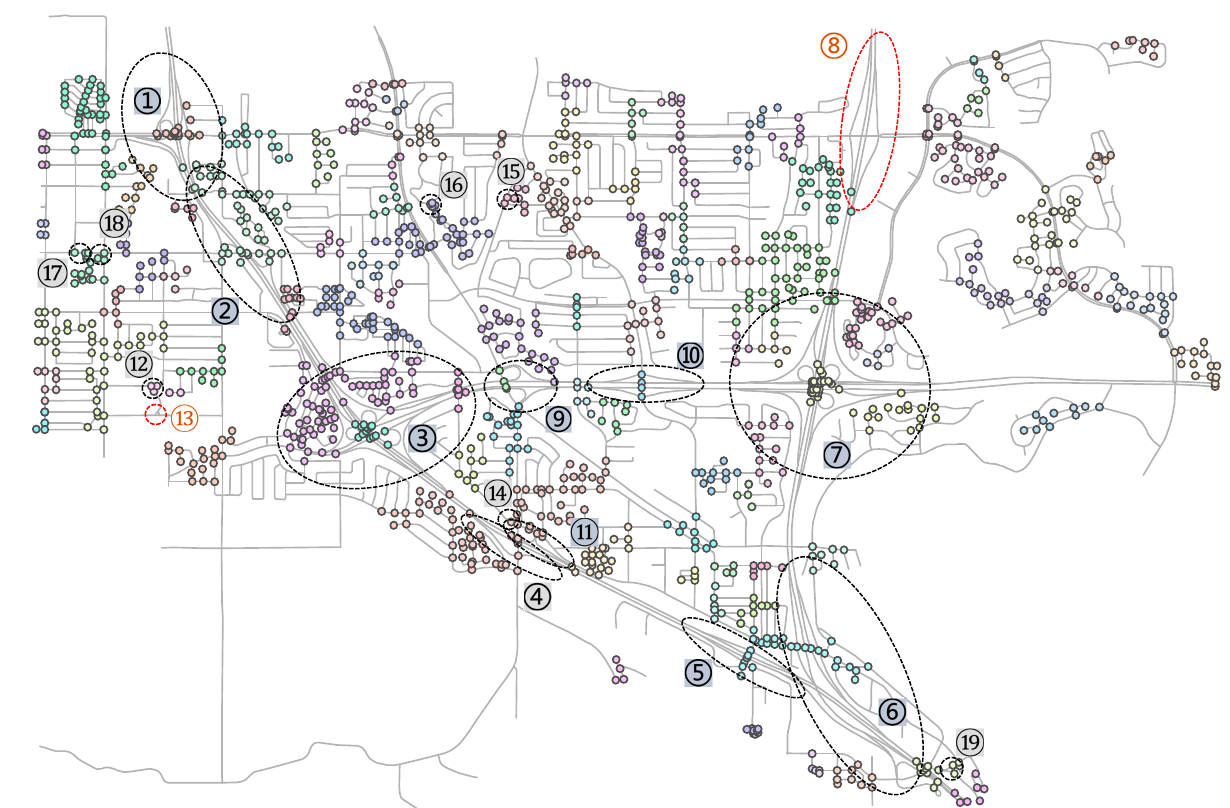
Figure 13. Complex junction detections using the approach proposed by Mackaness and Mackechnie (1999). The nineteen labels of the complex junctions to be identified are in two grey levels. Dark grey for various degree of inexactness, and light grey for overfitting. For those completely missing identified complex junctions, red dashed ellipses are used to circle the extents of